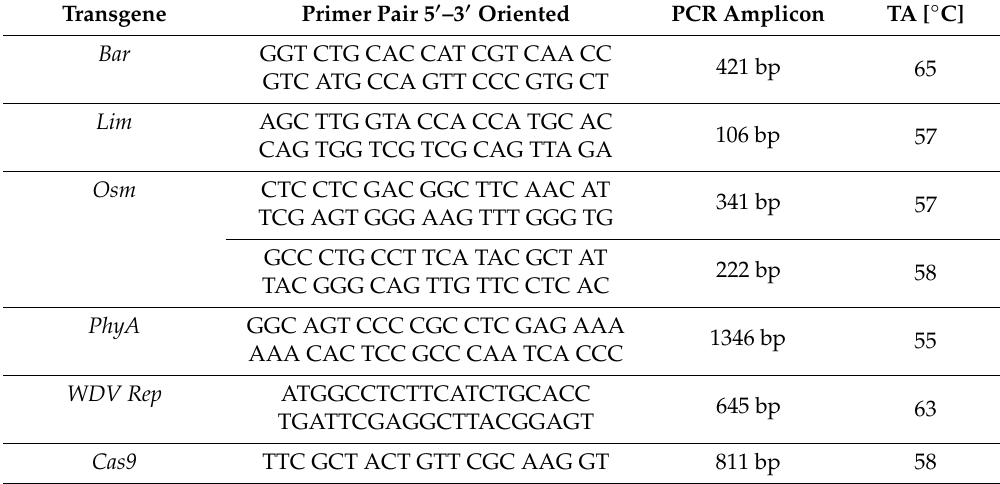
Table 2. List of genotyping primers, amplicon sizes and annealing temperatures (TA). Transgene Primer Pair 5 (cid:48) –3 (cid:48)